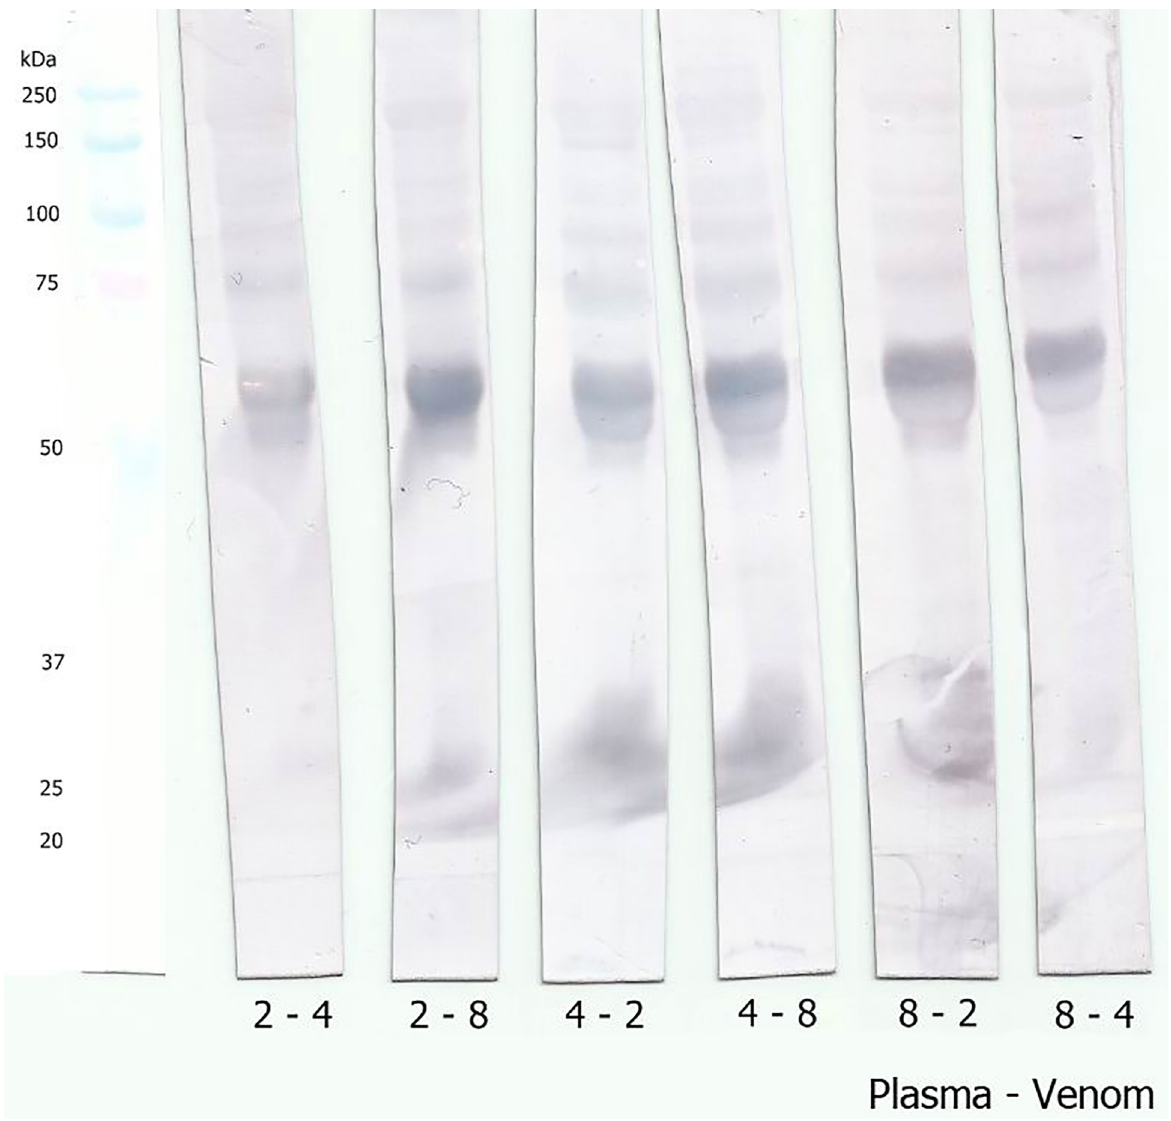
Fig 5. Cross-reactivity between plasmas and venoms from different specimens of B . moojeni . B . moojeni plasma proteins from specimens Bm2, Bm4, and Bm8 (20 μ g of protein) were fractionated by SDS-PAGE (10%, under reducing conditions), electrotransferred onto PVDF membranes, and incubated with the non-self venom prior to the incubation step with antibothropic serum. The first number below the membrane strips corresponds to the plasma specimen number and the second number corresponds to the venom specimen number.